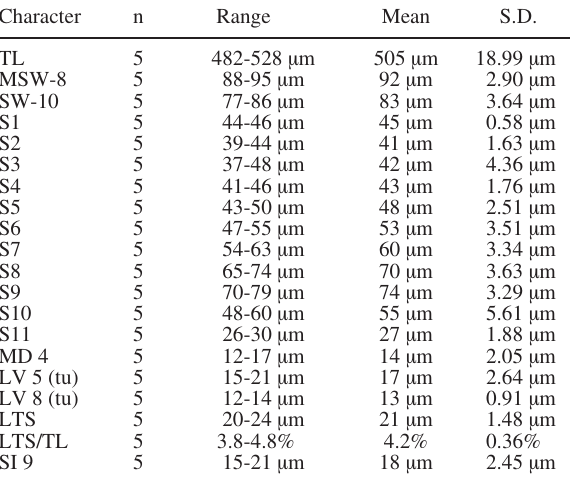
Table 1. – Measurements of adult Echinoderes rex n. sp. from the western Pacific Ocean, the Korea Strait, including number of measured specimens (n) and standard deviation (SD). Abbrevia- tions: LTS: lateral terminal spine; LV: lateroventral; MD: middorsal spine; MSW-8: Maximum sternal width, measured on segment 8 in this species; S: segment lengths; SI: sieve plate length; SW-10, standard width, always measured on segment 10; TL: trunk length; (tu): tubules.